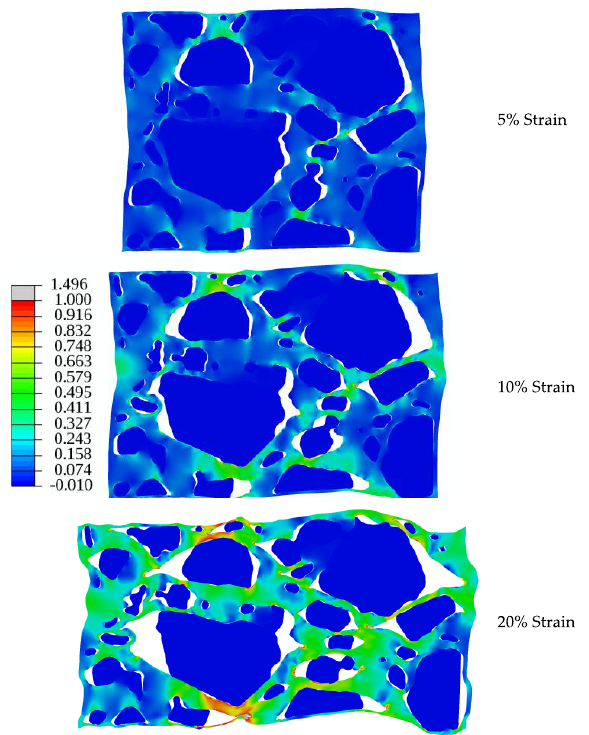
Figure 10. Maximum principal strain during macroscale compression of the meshed sample in Figure 9, following the general delamination behavior observed with the experimental sample CF75H . Failure of the crystal/binder interfaces occurs in isolated regions at first (5% strain). More surfaces are apparent at 10% strain with continued void growth at 20% strain.